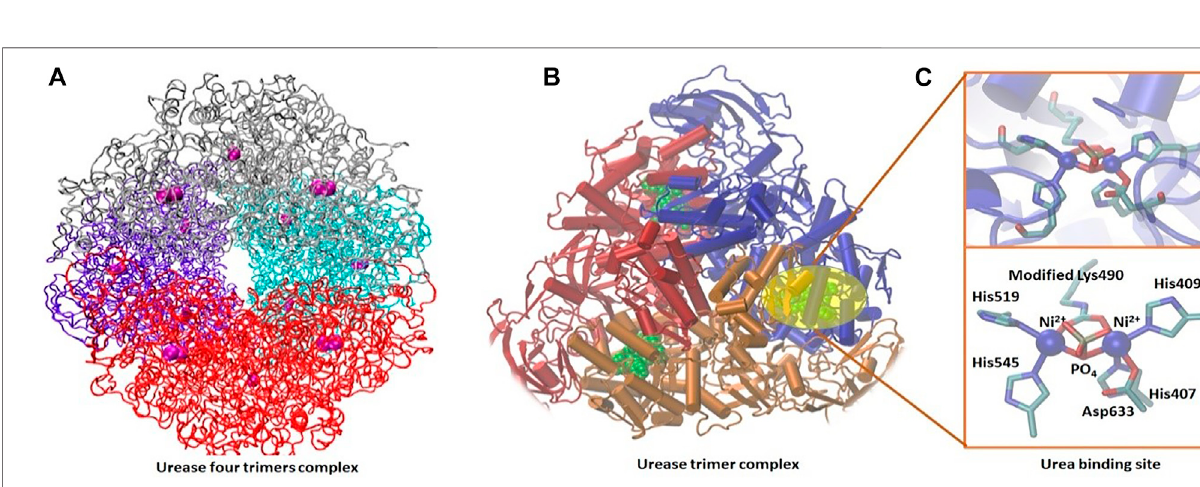
Frontiers in Bioengineering and Biotechnology |